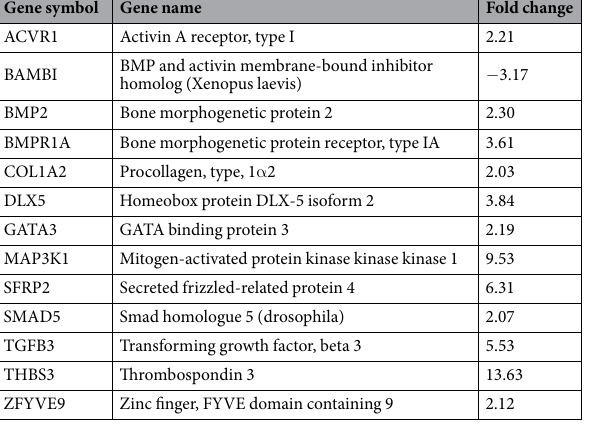
Table 6. List of genes belonging to Tgf β /Bmp signaling pathway that were significantly over expressed between week 1 and 2 (positive value indicates up-regulation at week 2).